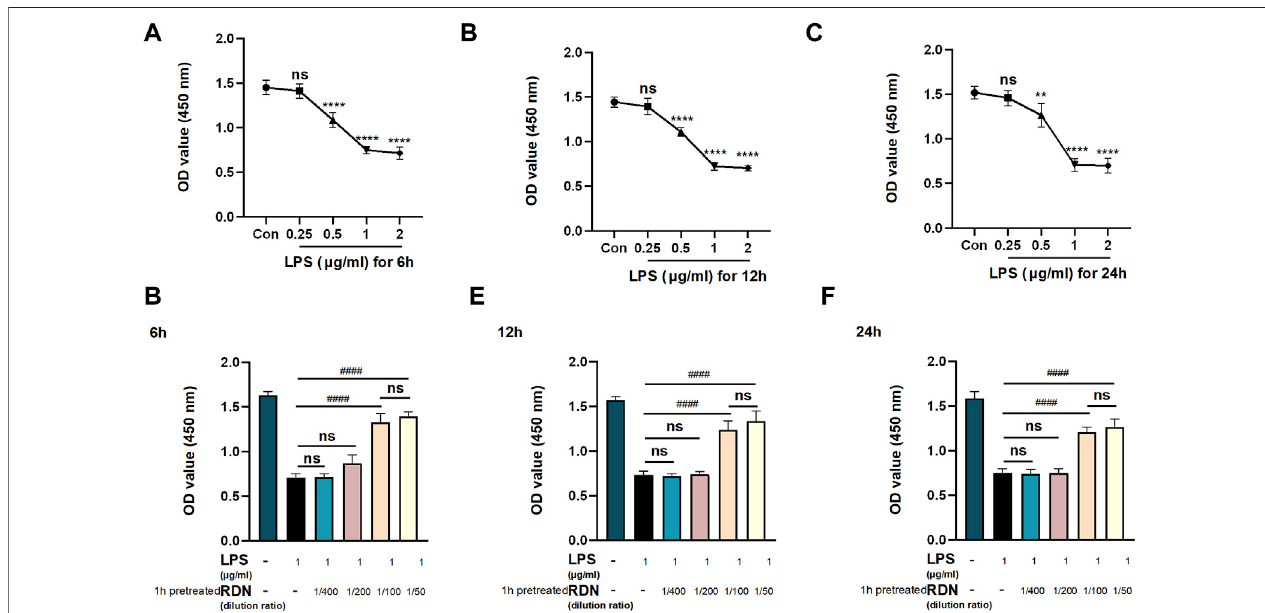
FIGURE 5 | Pre-study to detect ef fi cient time points and concentrations. CCK-8 was used to evaluate cell viability to fi nd ef fi cient concentrations and key points. HUVECsweretreatedwithLPS(0.25 μ g/ml,0.5 μ g/ml,1 μ g/ml,2 μ g/ml)for6 h (A) ,12 h (B) ,and24 h (C) to fi ndef fi cientconcentrationandtimepointofLPS.HUVECs werestimulatedwithLPS(andRDN)andcultured for6 h (D) ,12 h (E) ,and24 h (F) to fi ndef fi cient concentrationand timepointofRDN. TheRDNgroupwaspretreated with cells diluted into different concentrations ofRDN injection (dilution in 1/400, 1/200, 1/100, 1/50) for 1 h. Dataare presented as mean ± SD ( n = 3per group) of therepresentativedatafromthreeindependentexperiments;** p < 0.01,**** p < 0.001, #### p < 0.001.Theasterisk(*)representsthegroupisstatisticallydifferentfromthe Con group.